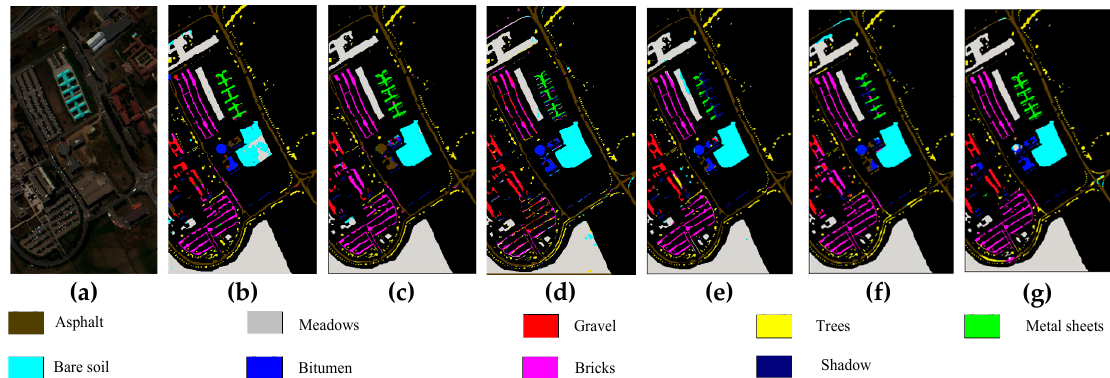
Figure 14. Pavia. ( a ) False-color composite image. The classification maps using ( b ) EMP-SVM; ( c ) CNN; ( d ) SSRN; ( e ) VGG; ( f ) SST-FA; ( g ) T-SST-L.